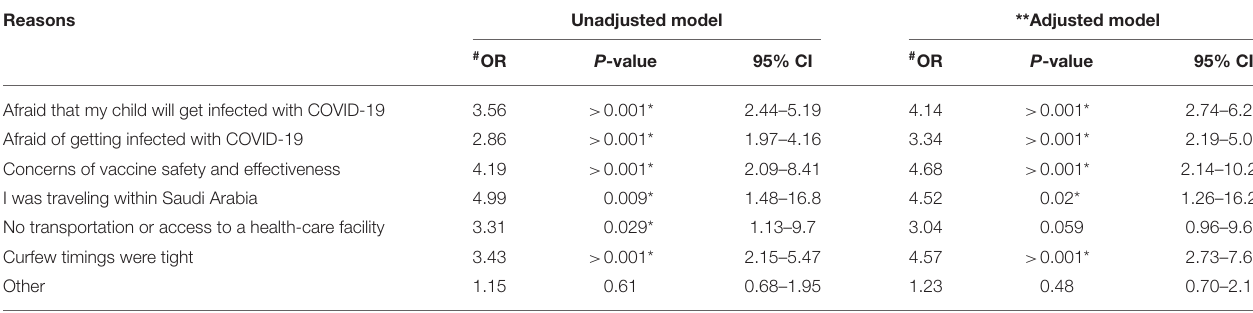
TABLE 4 | Unadjusted and adjusted regression models for reasons for delayed vaccination.